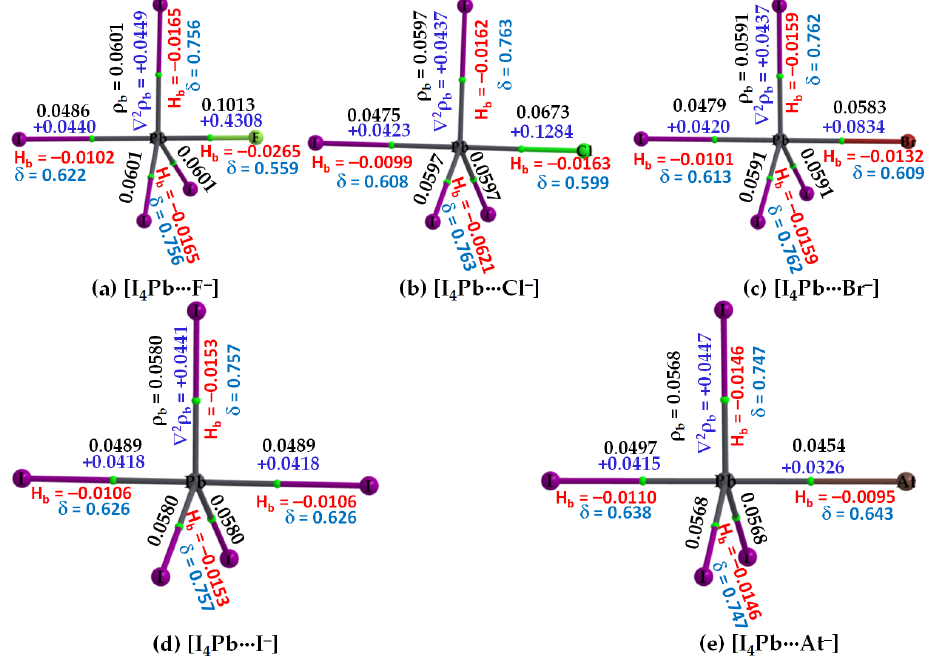
Figure 8. ( a – e ) [ ω B97X-D/def2-QZVPPD] level QTIM-based molecular graphs of [I 4 Pb ··· X − ] (X = F, Cl, Br, I, At), showing the bond paths (solid and dotted lines in atom color) and bond critical points (tiny spheres in green) between bonded atomic basins. Large spheres represent the atomic basins, with atoms labeled. The charge density ( ρ b ), the Laplacian of the charge density ( ∇ 2 ρ b ), the total energy density (H b ), and the delocalization index ( δ ) values are shown in black, blue, red, and faint-blue fonts (in a.u.), respectively.